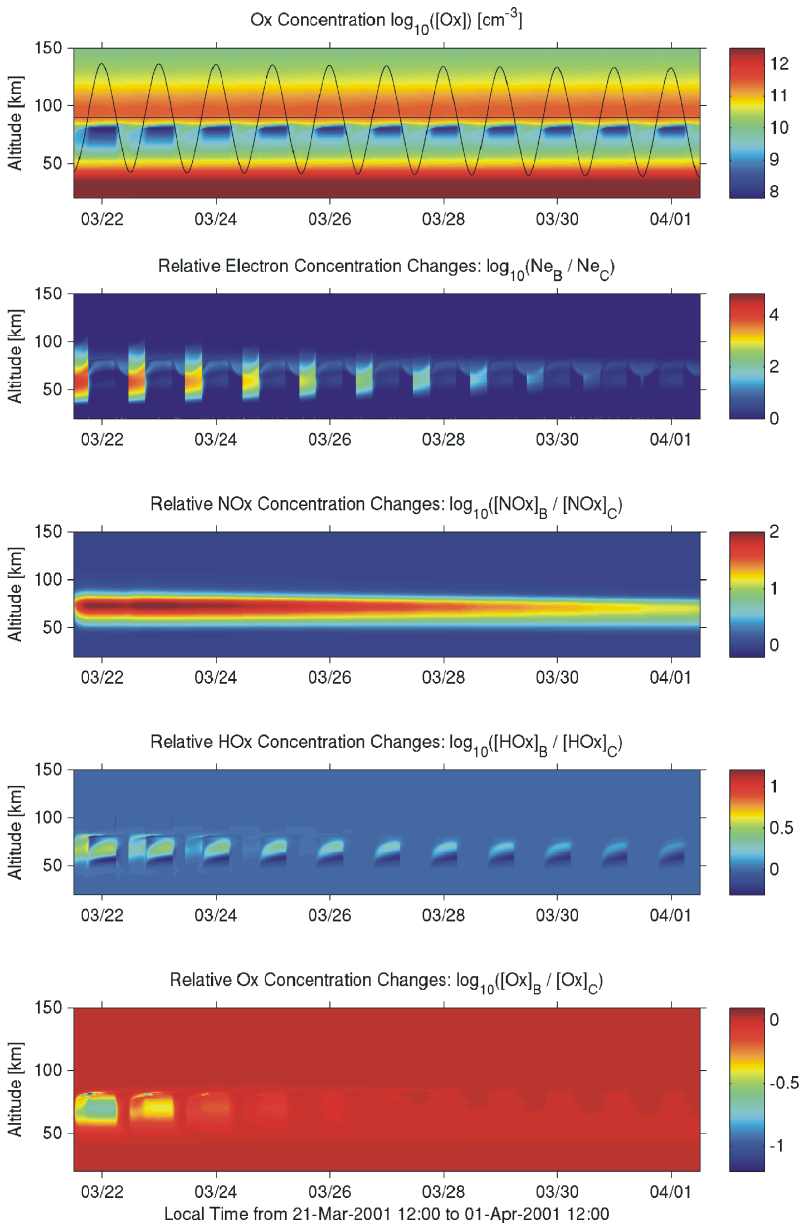
Fig. 10. The effect of the precipitation driven by a single station ground based RBR system-forced. The format is as shown in Fig. 5 driven by the precipitation fluxes shown in Fig.